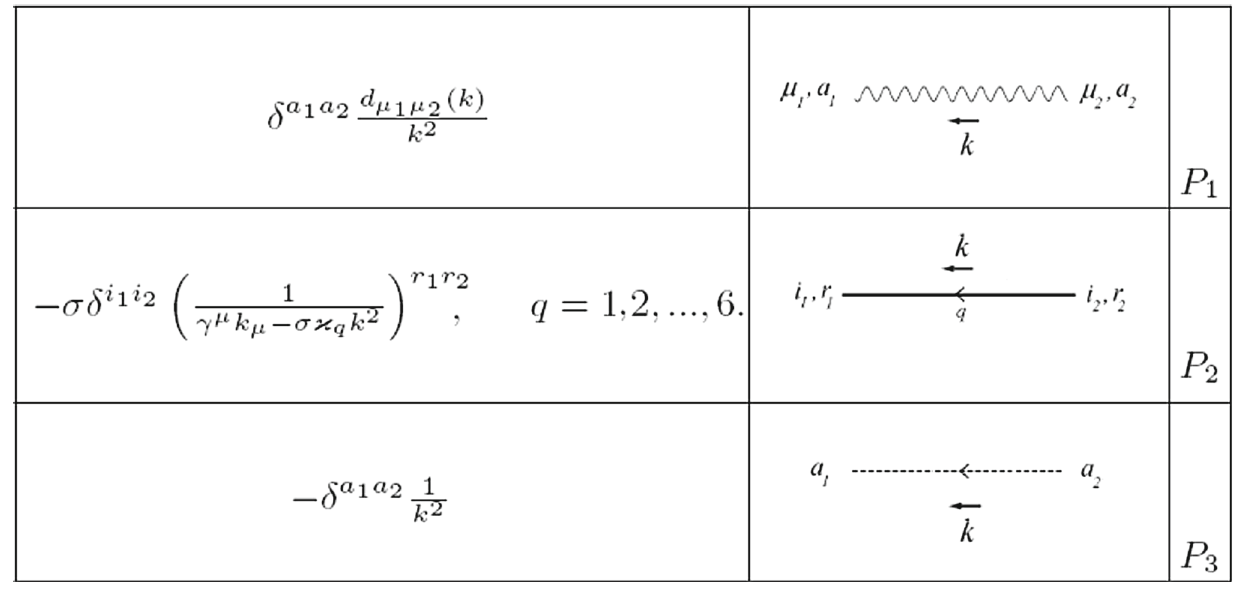
Fig. 2 The gluon, ghost and quark propagators for the renormalized fields